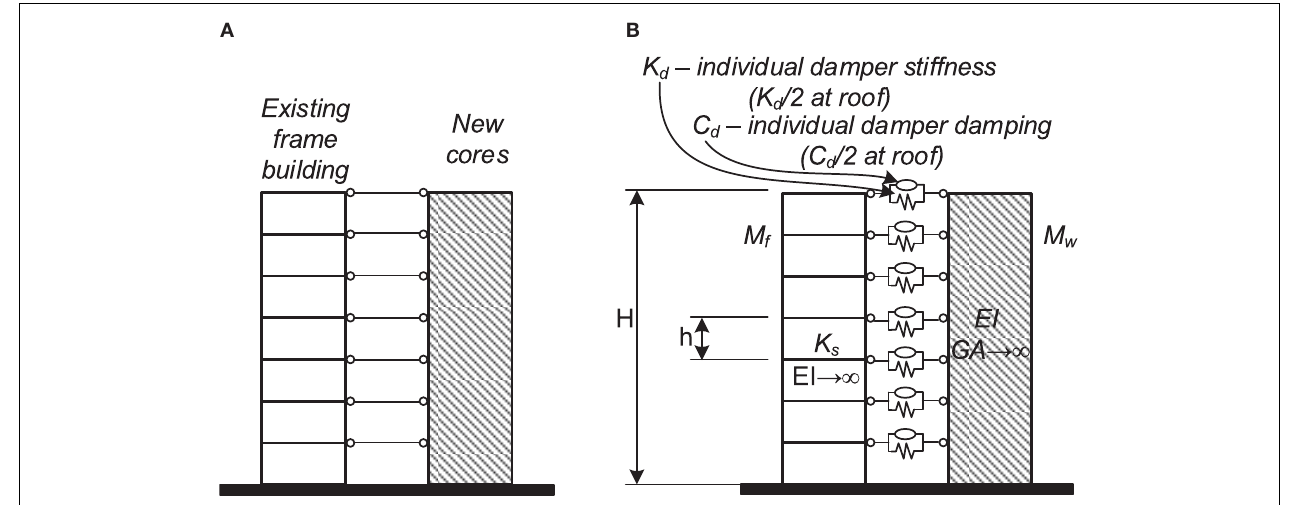
FIGURE 1 | Schematic of rehabilitation system: (A) wall–frame; (B) wall–EDD–frame .